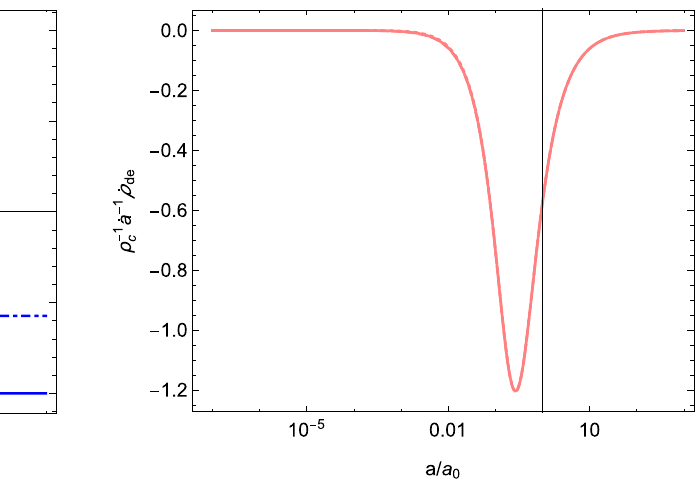
Fig. 8 The amount of deviation from a conserved SET, shown as a functionof a / a 0 .ThecalculationsarecarriedoutforgeneralizedRastall gravity by using the model parameters described in the